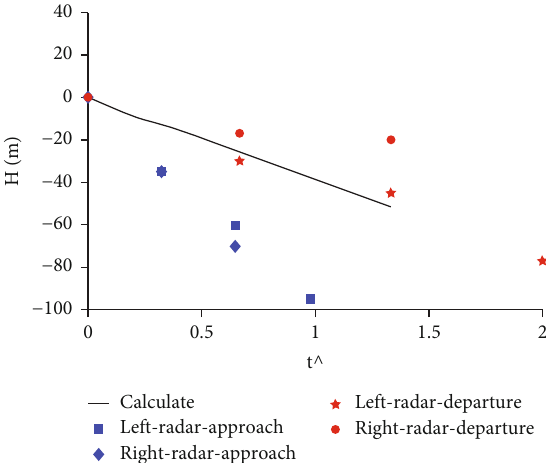
Figure 10: Comparison of wake vortex circulation attenuation between radar detection and numerical simulation results.